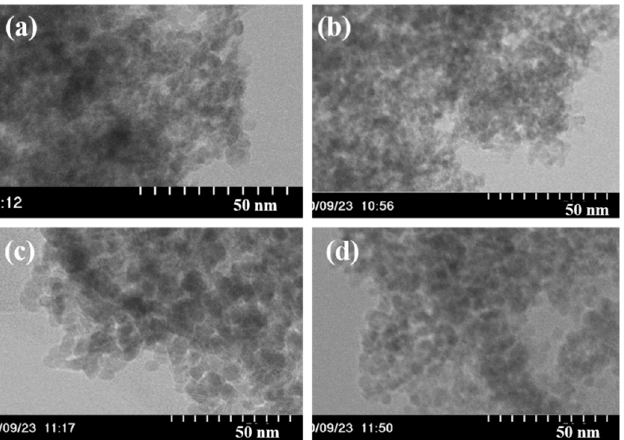
Figure 3. TEM images obtained for ZrO 2 nanoparticles synthesized at various temperatures: ( a ) 250 °C, ( b ) 300 °C, ( c ) 350 °C, and ( d ) 400 °C.